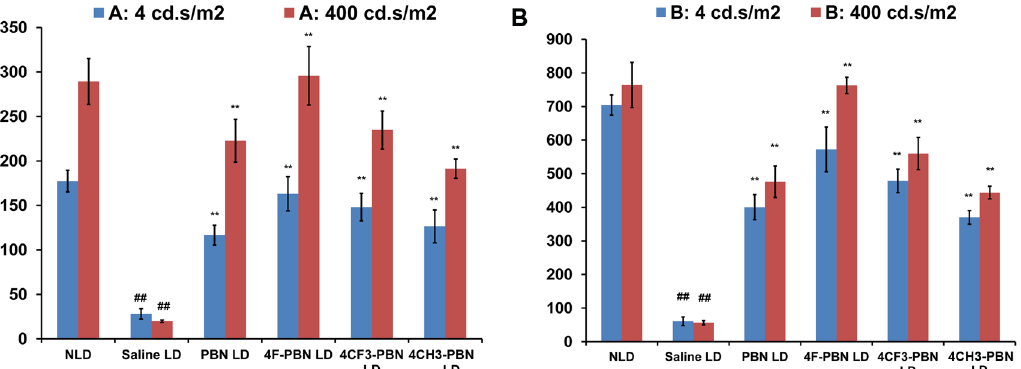
Fig 3. Systemically administered PBN and PBND protect rat retina from light damage. Electroretinographic (ERG) responses were recorded for a series of flash stimuli intensities at 0.04, 4, 200, 400, and 2000 cd.sec/m 2 . ERG responses presented here are from the intensities of 4 and 400 cd.sec/m 2 . The dim flash (4 cd.sec/m 2 ) stimulates the rod photoreceptor cells and the bright flash (400 cd.sec/m 2 ) stimulates both rod and cone photoreceptors. Therefore, the blue bars represent only rod responses and the red bars represent mixed response from both rod and cone photoreceptors. Fig 3A shows A- wave responses, and Fig 3B shows B-wave responses. NLD represents non-light-damaged group and LD represents light-damaged groups. [## = p < 0.001: NLD vs. LD saline-treated; * = p < 0.01 and ** = p < 0.001: LD saline vs. PBNDs; n = 4 – 6]